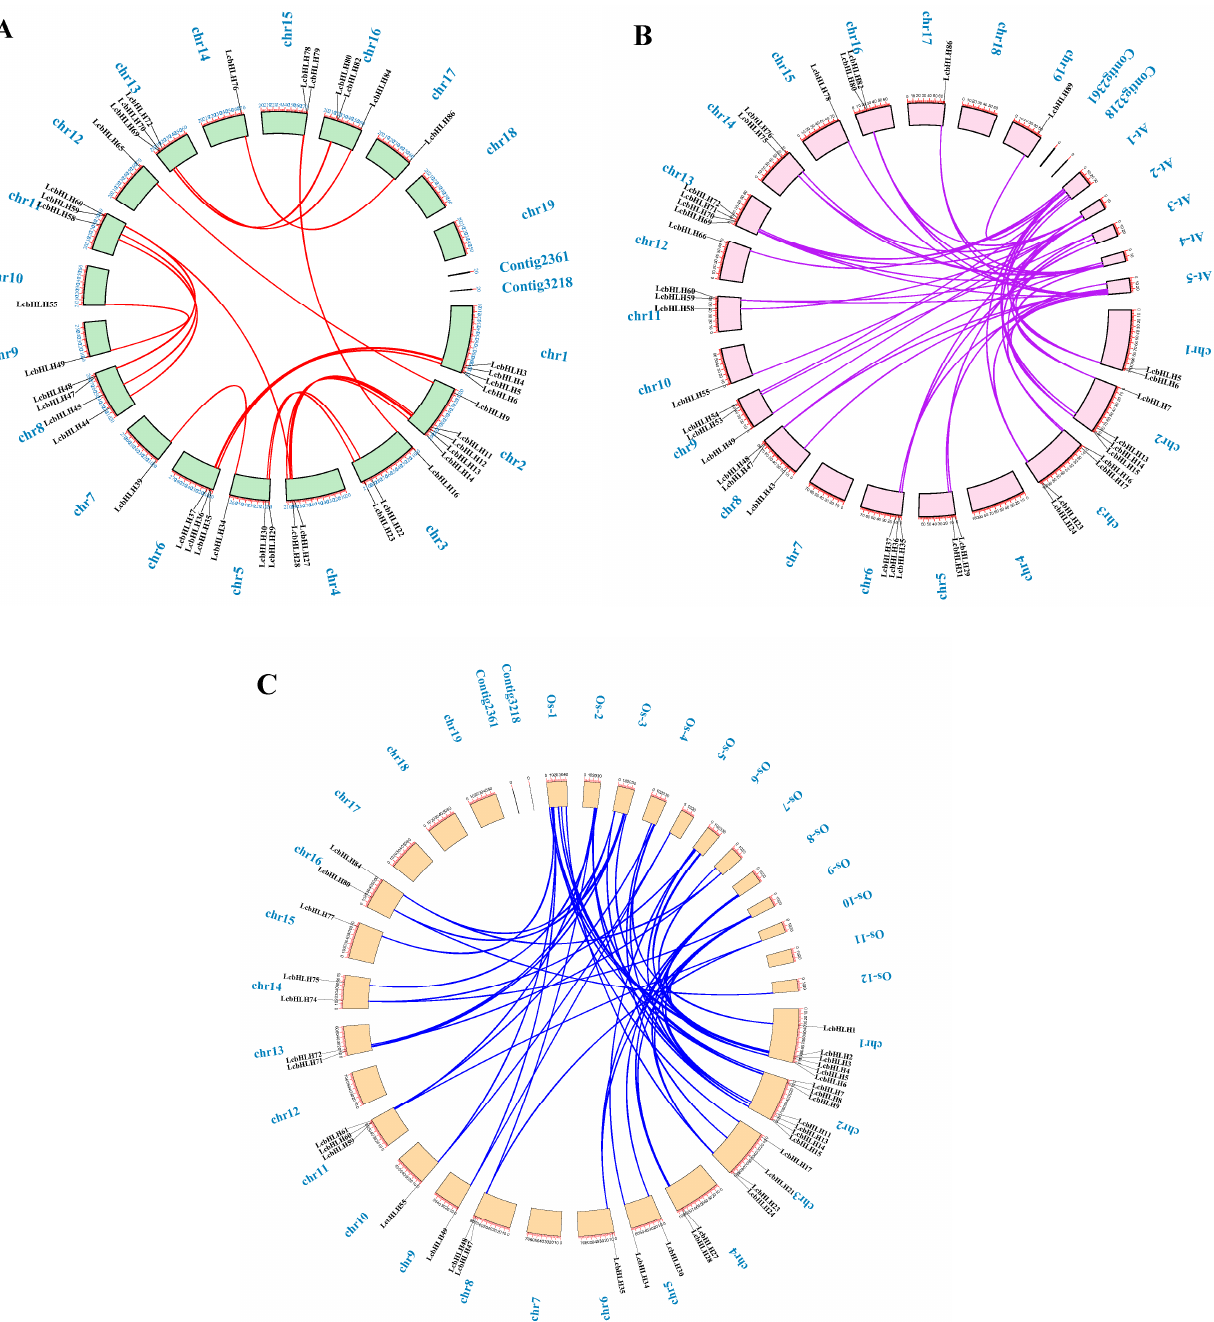
Figure 5. Fragment replication and chromosome distribution of bHLH genes in Liriodendron chinense . ( A ) Nineteen chromosomes were represented by green segments, red lines connected with homologous genes. ( B ) Collinearity analysis of Liriodendron chinense and Arabidopsis thaliana ; ( C ) Collinearity analysis of Liriodendron chinense and Rice. The gene pairs between them are represented by purple lines and blue lines respectively.